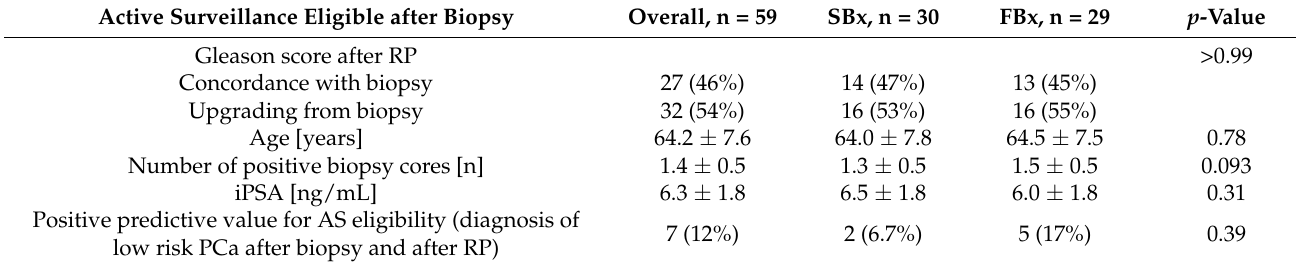
Table 4. Baseline characteristics of patients undergoing FBx versus SBx assessed as eligible for active surveillance after biopsy. Values are presented as mean ± standard deviation or n (%). The t -test was performed for comparison between continuous variables and the chi-squared test between categorical variables. AS: active surveillance, iPSA: prostate-specific antigen at FBx, RP: radical